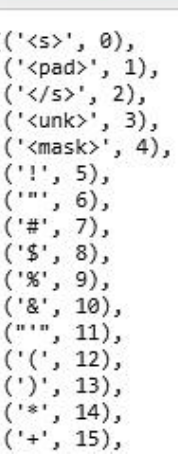
Figure 4. Token dictionary of ‘Ukrainian Roberta’.